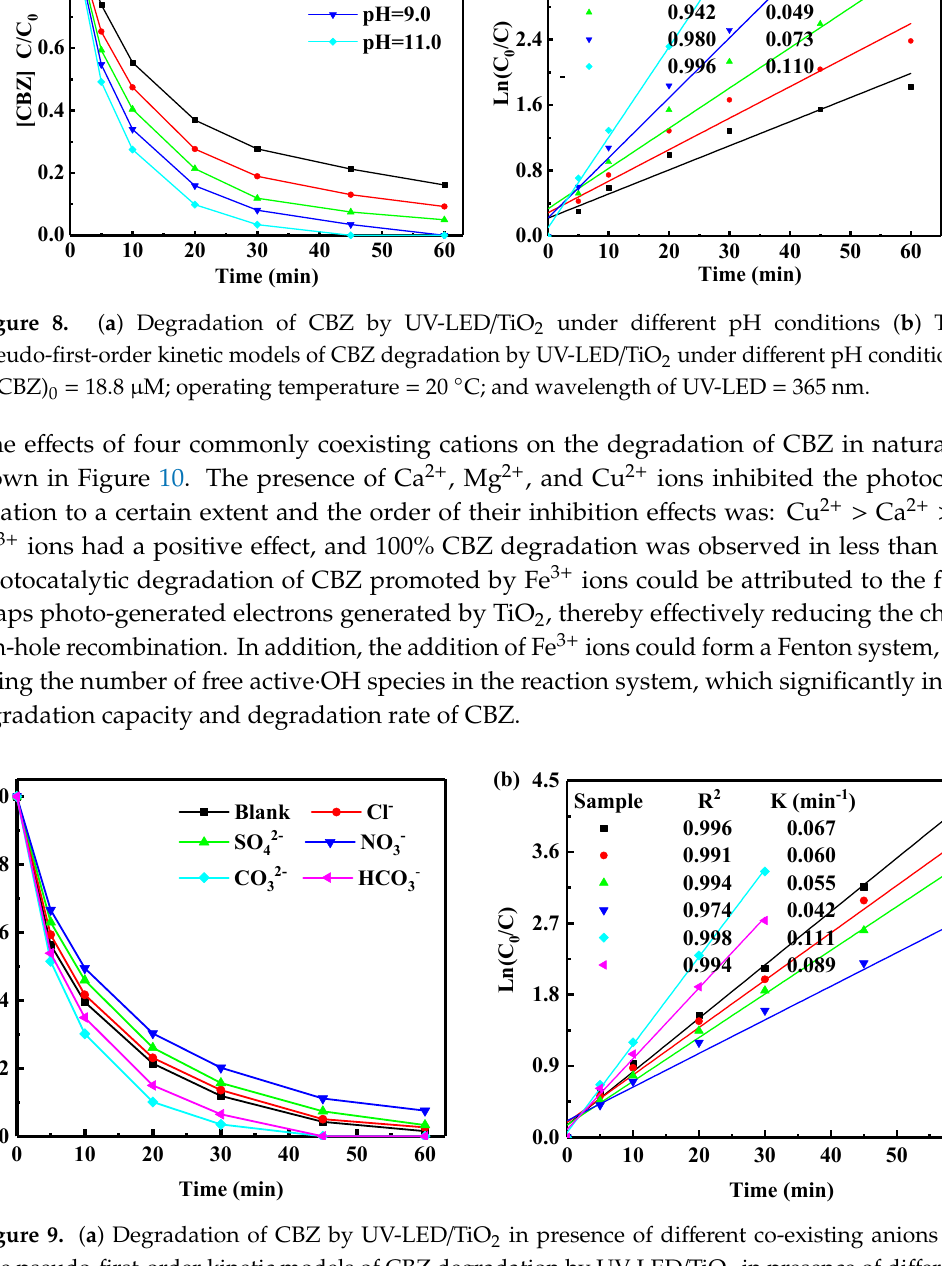
Figure 10. Degradation of CBZ by UV-LED/TiO 2 with different co-existing cations. 251